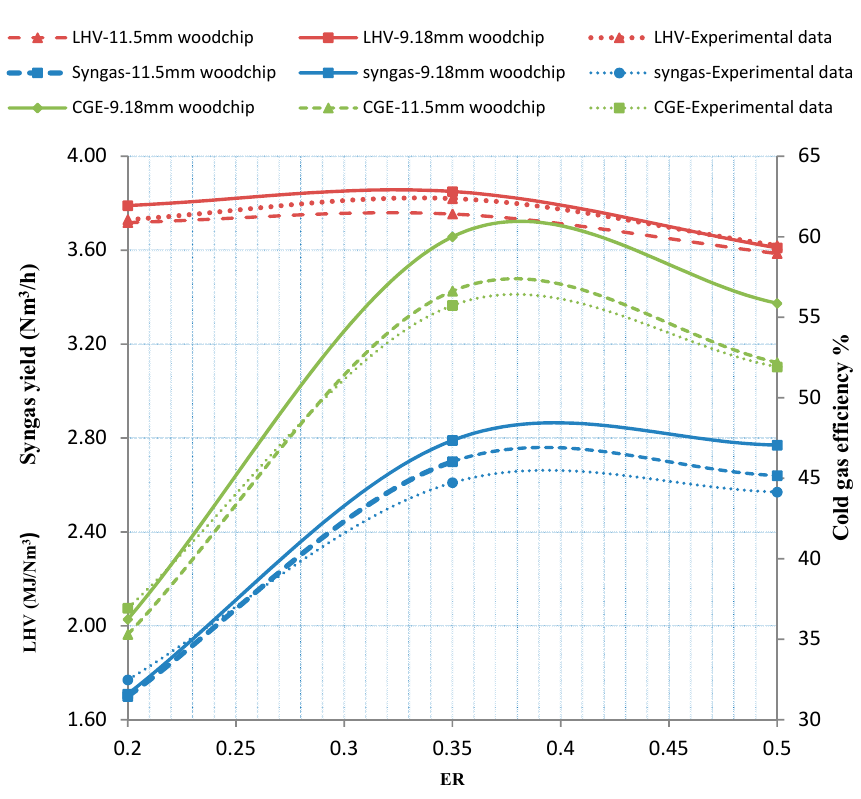
Figure 7. Variation of Syngas yield lower heating value (LHV) and cold gas efficiency (CGE) of syngas as a function of Equivalences Ratio (ER).